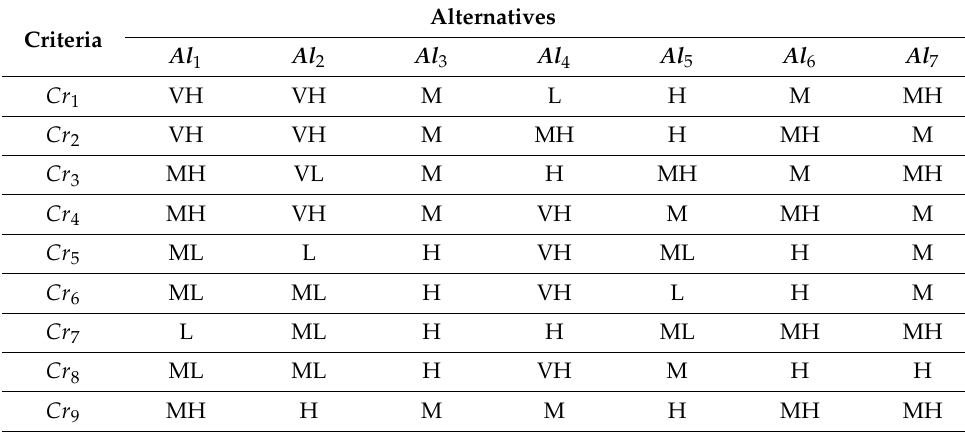
Table 4. Linguistic variables decision matrix from the third